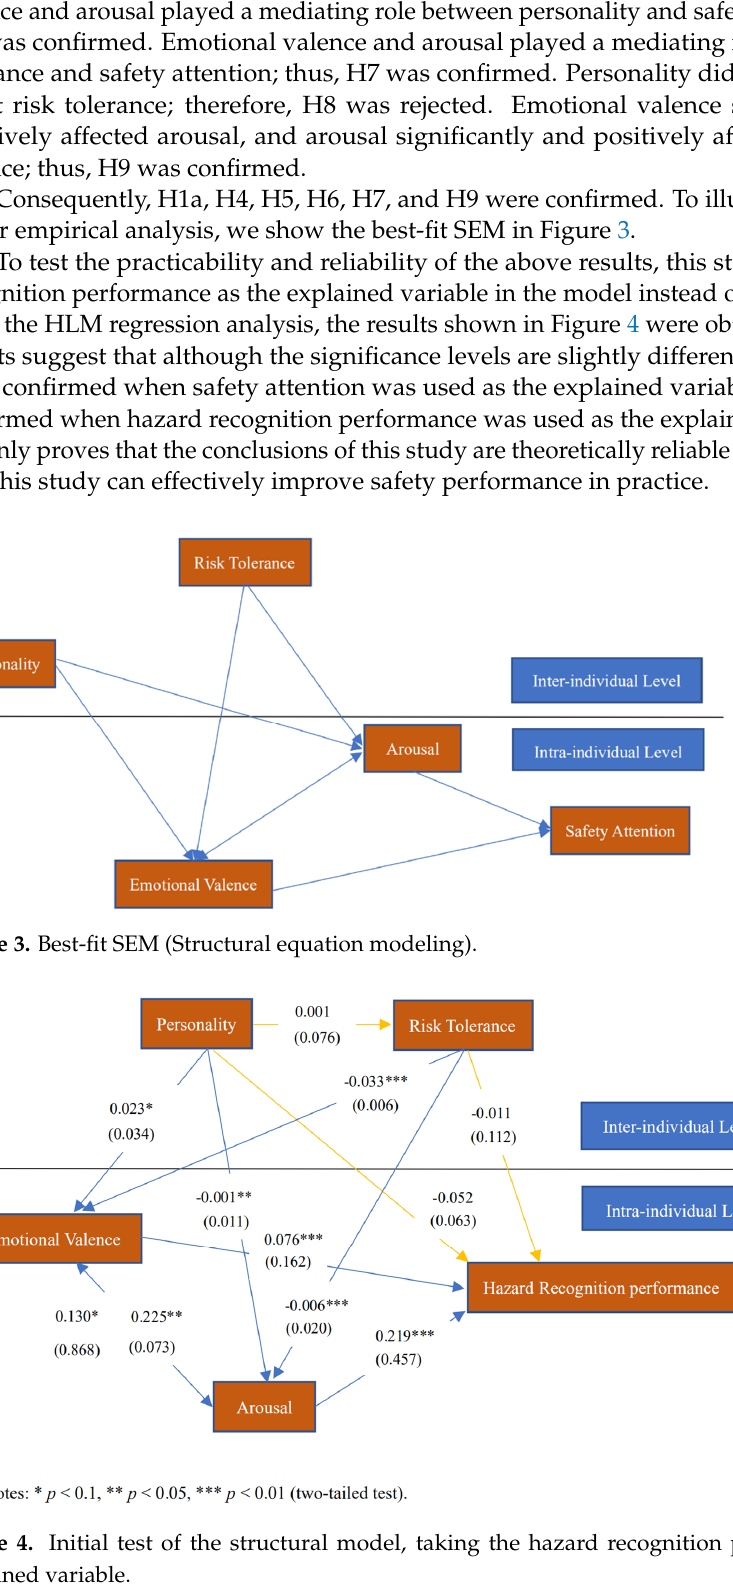
Figure 2. Initial test of the hypothesized structural model.